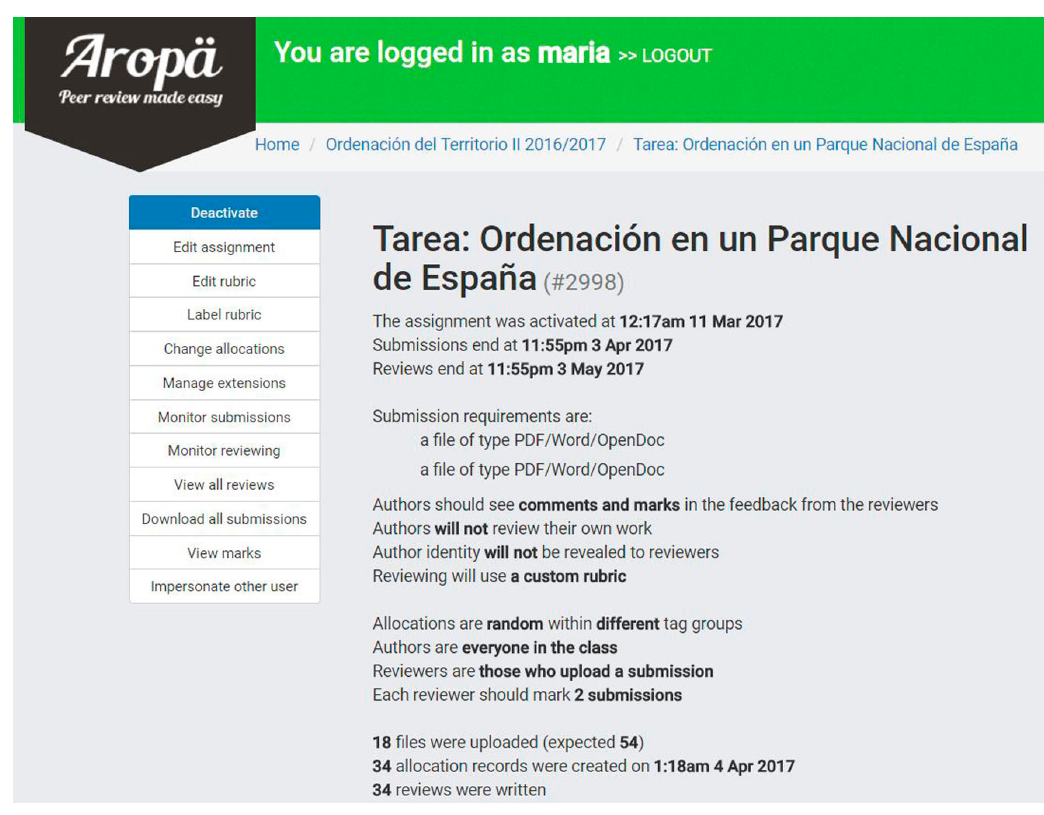
Figure 4. Aropä task for students.